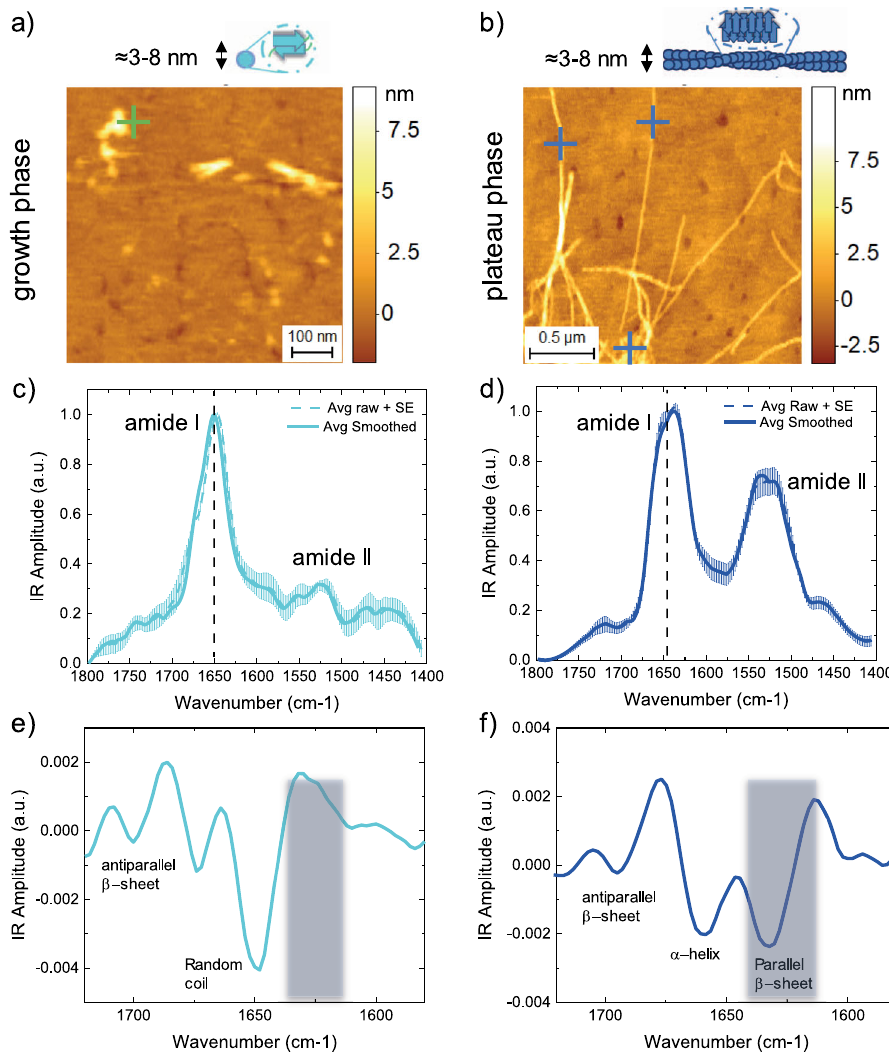
Fig. 2 Single molecule measurements of secondary and quaternary structure of A β 42 aggregates. a , b AFM-IR morphology maps of single oligomeric (light blue sphere) ( a ) and fi brillar species (dark blue rod) ( b ) of A β 42. The morphology of the aggregates was reproducible and consistent on at least fi ve independent and randomly chosen areas on the surface of each sample. c , d Nanoscale localised IR absorption spectra of oligomeric ( c ) and fi brillar species ( d ) of A β 42. We represent two spectra: (i) the average + SE of the raw spectra and (ii) the average + SE of the preprocessed spectra by applying an adjacent averaging fi lter (5 pts) and a Savitzky – Golay fi lter (second order, 15 pts). At least fi ve different raw spectra at each position (coloured crosses) were acquired. e , f The second derivatives of the spectra are calculated with a Savitzky – Golay fi lter (second order, 15 pts) to deconvolve the major secondary structural contributions of the oligomeric and fi brillar